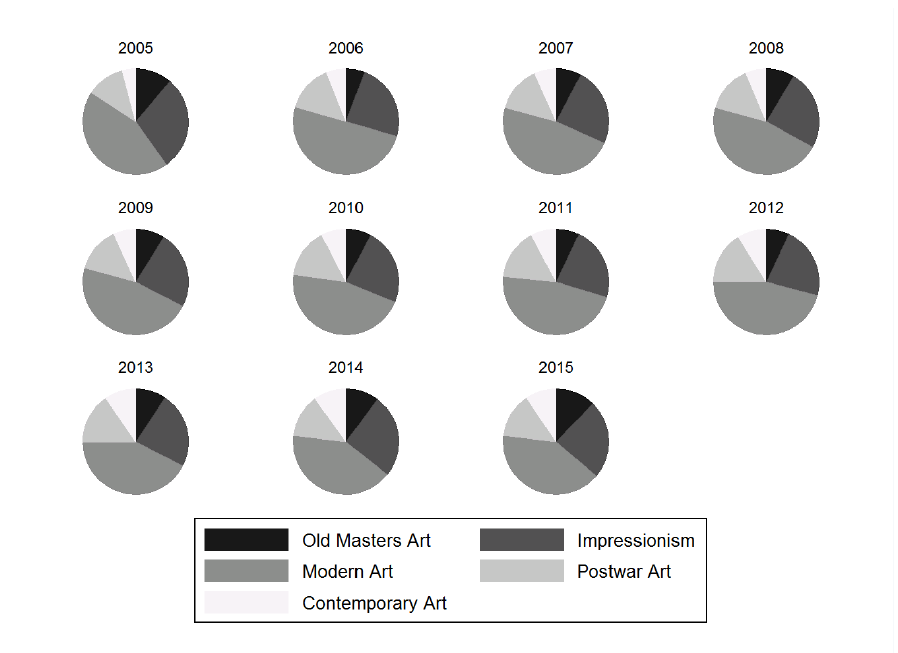
Figure 5. Shares of sectors by year.